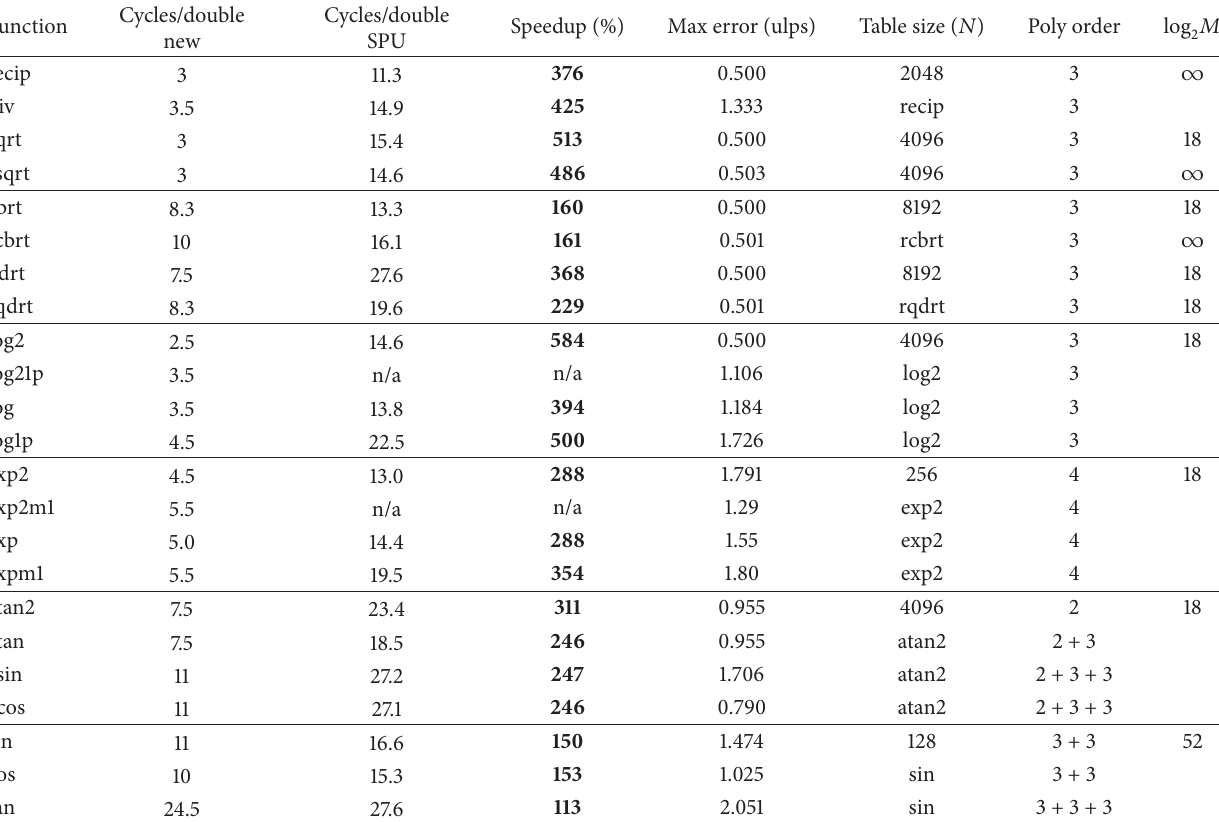
Table 1: Accuracy, throughput, and table size (for SPU/double